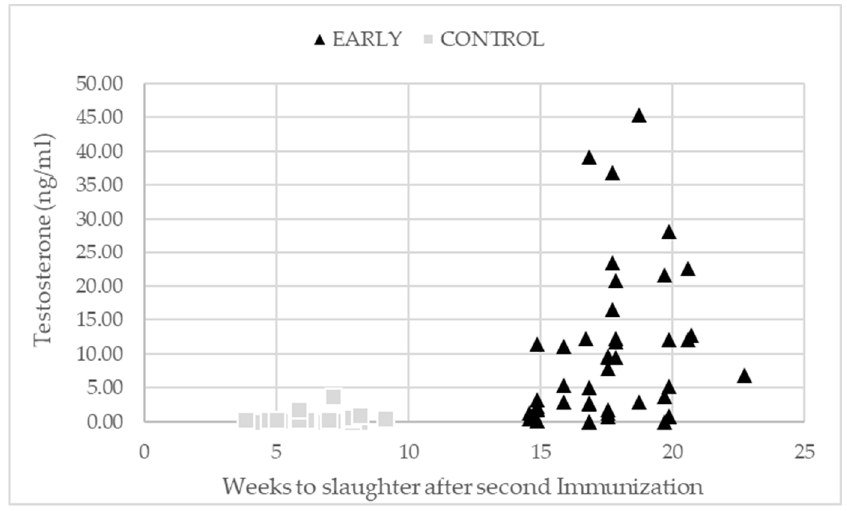
Figure 4. Testosterone levels depending on the number of weeks from the second immunization to slaughter according to the immunization scheme.